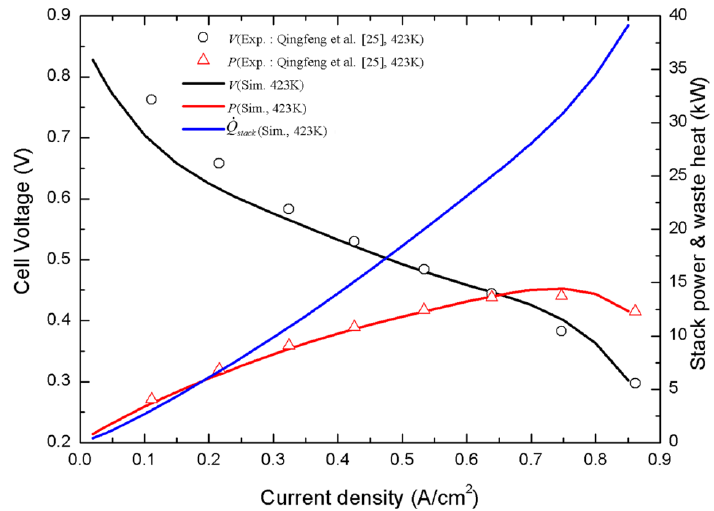
Figure 6. Simulation and experiment comparison of polarization curves for a HT-PEMFC, stack power curve, and waste heat curve as a function of current density.